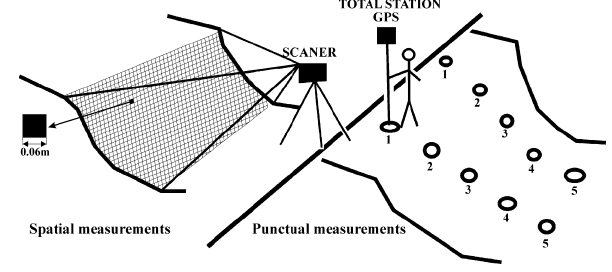
Fig. 2. The spatial measurements using the 3-D scanner and the punctual measurements using the Total Station and GPS.